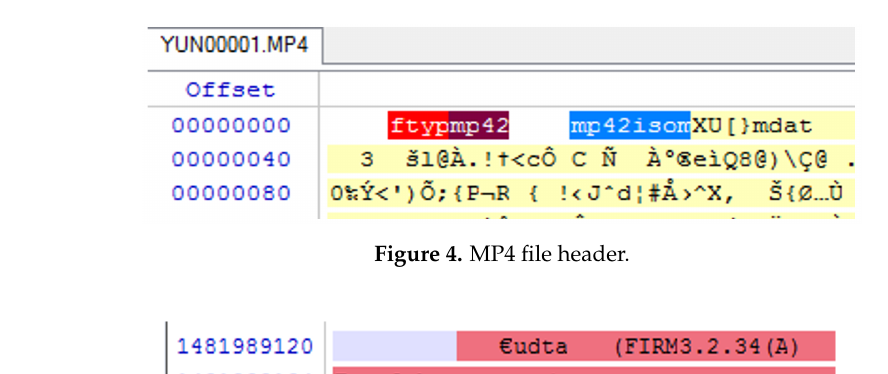
Figure 4. MP4 file header.